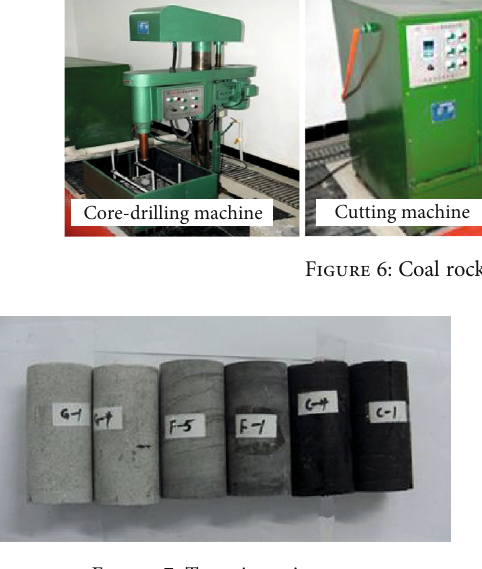
Figure 7: Test piece